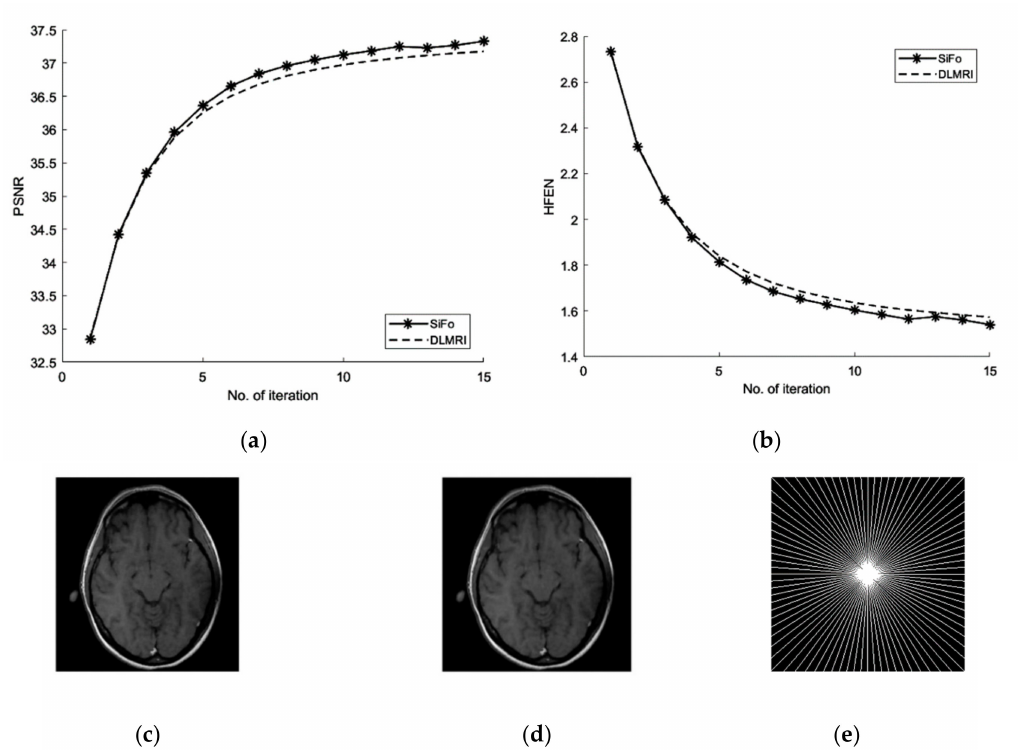
Figure 6. Algorithms performance of SiFo vs DLMRI in a noisy case with radial sampling mask. ( a ) PSNR vs iterations for a phantom image; ( b ) HFEN vs iterations for a phantom image; ( c )